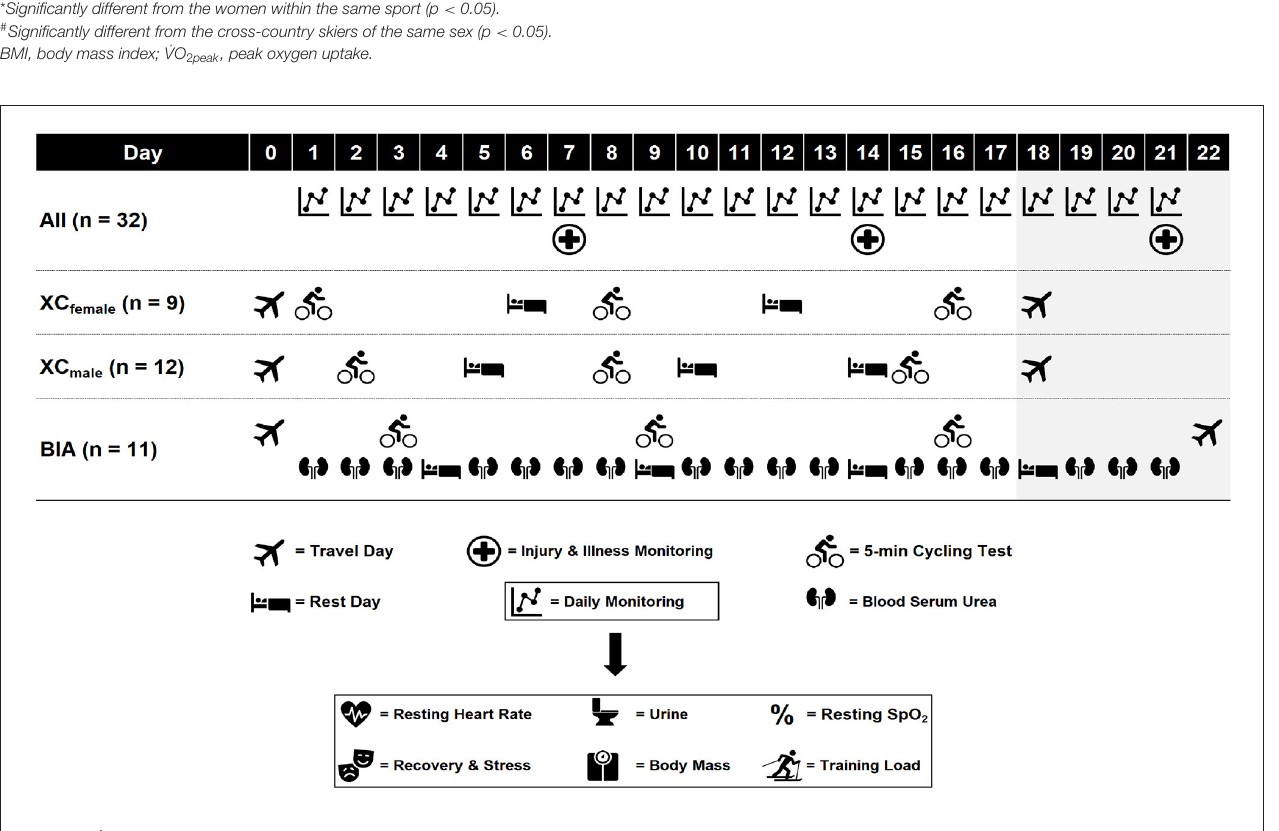
FIGURE 1 | Schematic overview of measures during the altitude training camp. All, all athletes; XC female , female cross-country skiers; XC male , male cross-country skiers; BIA, biathletes; SpO 2 , peripheral oxygen saturation. Shaded area indicates biathletes only.